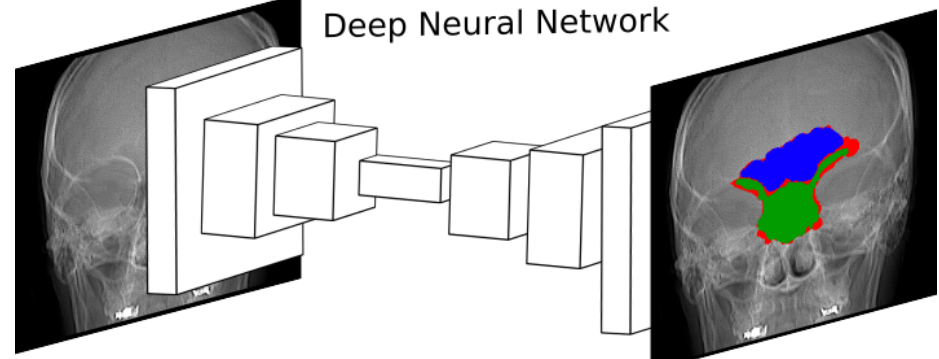
Figure 6. Diagram showing the approximation followed in [147]. A deep ConvNet is trained to segment frontal sinuses in skull radiographs. A real outcome of the network is displayed on the right, where the frontal sinus, the occlusion region, and the segmentation error are displayed in blue, green and red, respectively. The frontal sinus is an anatomical region of extremely diffuse boundaries and complex morphology. In fact, its lower limit overlaps other anatomical structures, hardening the segmentation